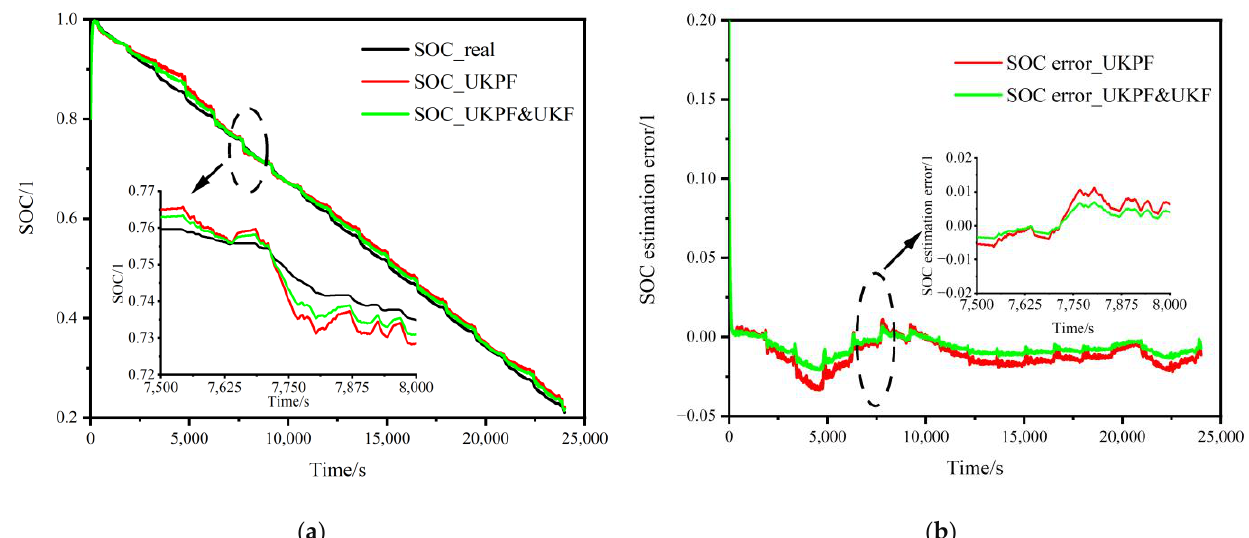
Figure 12. Joint estimation simulation graph. (a) SOC_discharge estimation based on the UKPF and multi-time scale joint estimation algorithms; (b) SOC_discharge estimation error based on the UKPF and multi-time scale joint estimation algorithms.